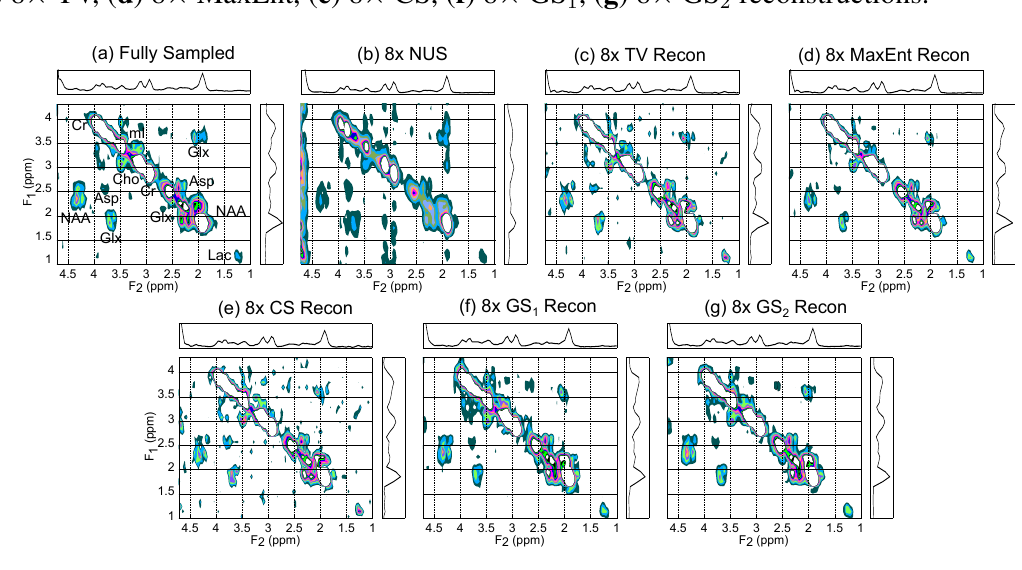
Figure 2. Select 2D COSY spectrum from the central voxel of a ( a ) Fourier transformed, fully sampled 4D EP-COSI brain phantom scan, ( b ) Fourier transformed 8 × NUS, and the ( c ) 8 × TV, ( d ) 8 × MaxEnt, ( e ) 8 × CS, ( f ) 8 × GS